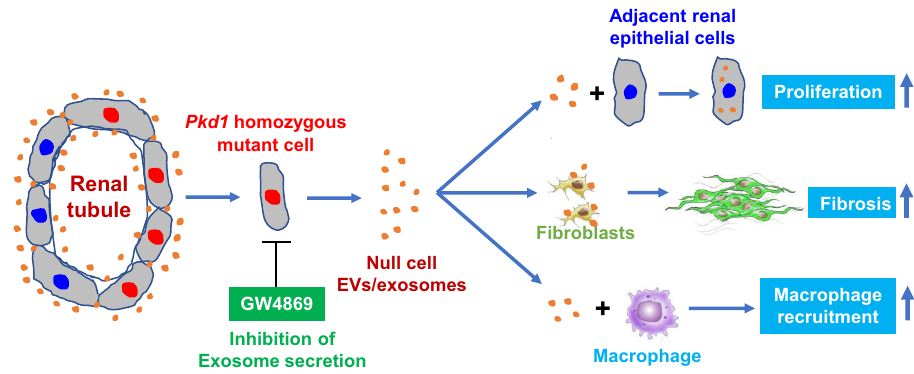
Fig. 10 Working model of the “ cystic extracellular vesicles/exosomes theory ” in ADPKD. Renal cysts in ADPKD are proposed to be clonal in nature (derive from a single cell) and can arise from cells with inherited heterozygous germline mutations of PKD1 or PKD2 on one allele and a somatic mutation inactivating the remaining normal allele (two-hit model). After the second hit, the homozygous PKD1 mutant renal epithelial cell may be via its secreted extracellular vesicles/exosomes, which can be secreted from apical and basolateral sides of cyst-lining epithelial cells, to affect the biology and function of neighboring cells, including heterozygous renal epithelial cells, fi broblasts, and macrophages during cyst initiation and expansion. In particular, cystic cell- derived EVs/exosomes could (1) lower the levels of polycystin to a critical threshold to promote Pkd1 heterozygous renal epithelial cell proliferation and cyst growth ( “ threshold model ” ); (2) activate interstitial renal fi broblasts to promote renal fi brosis; and (3) induce the recruitment of macrophages to pericystic and interstitial regions in cystic kidneys. Inhibition of exosome biogenesis and release with GW4869 delays cyst growth in vivo. This “ cystic extracellular vesicles/exosomes theory ” addresses a long-time issue in PKD fi eld of if and how ADPKD gene null renal epithelial cells affect the biology and function of neighboring cells, which integrates the “ two-hit model ” and “ threshold model ” together in renal cyst initiation and progression, and suggests a therapeutic potential for ADPKD treatment by targeting abnormal exosome